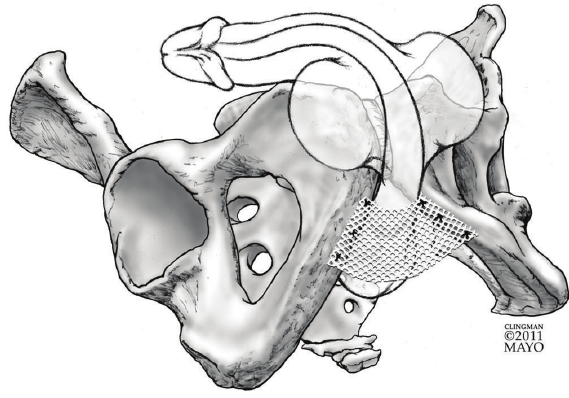
Figure 1: Graphical representation of the bone-anchored sling.